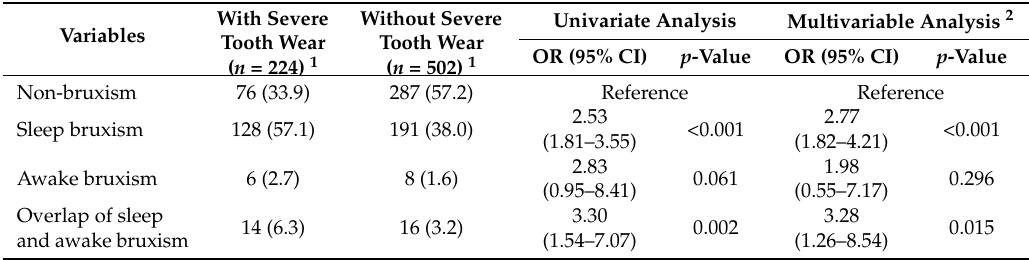
Table 2. Associations of severe tooth wear for the whole dentition with different types of bruxism using binary logistic